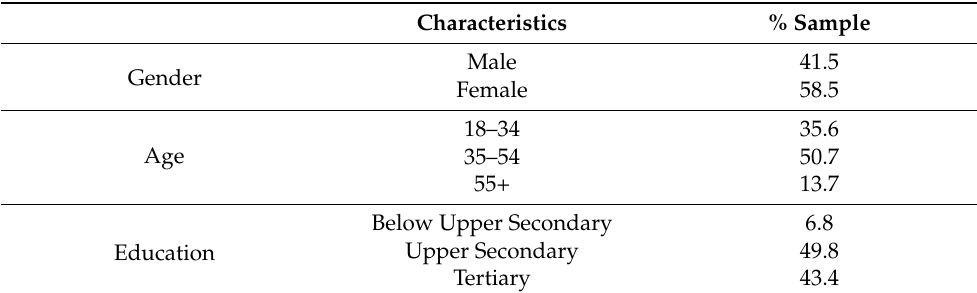
Table 1. Descriptive statistics of the sample ( n =